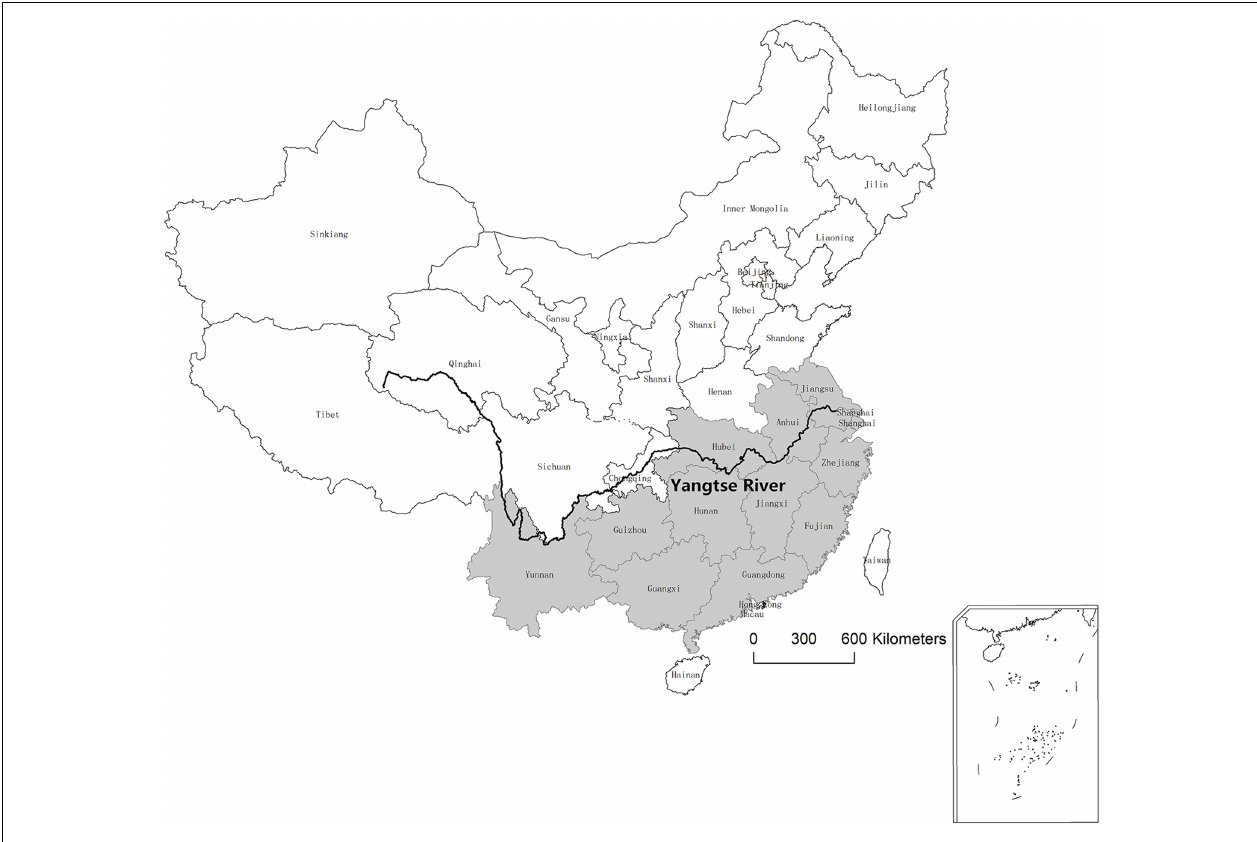
FIGURE 2 | Distribution of B. orientalis in water buffalo in China. Black line, Yangtze River; gray, provinces which have been reported B. orientalis positive are marked with gray. TABLE 1 | Features of Babesia orientalis draft genome compared with that of Plasmodium falciparum , Theileria parva, and B. bovis .